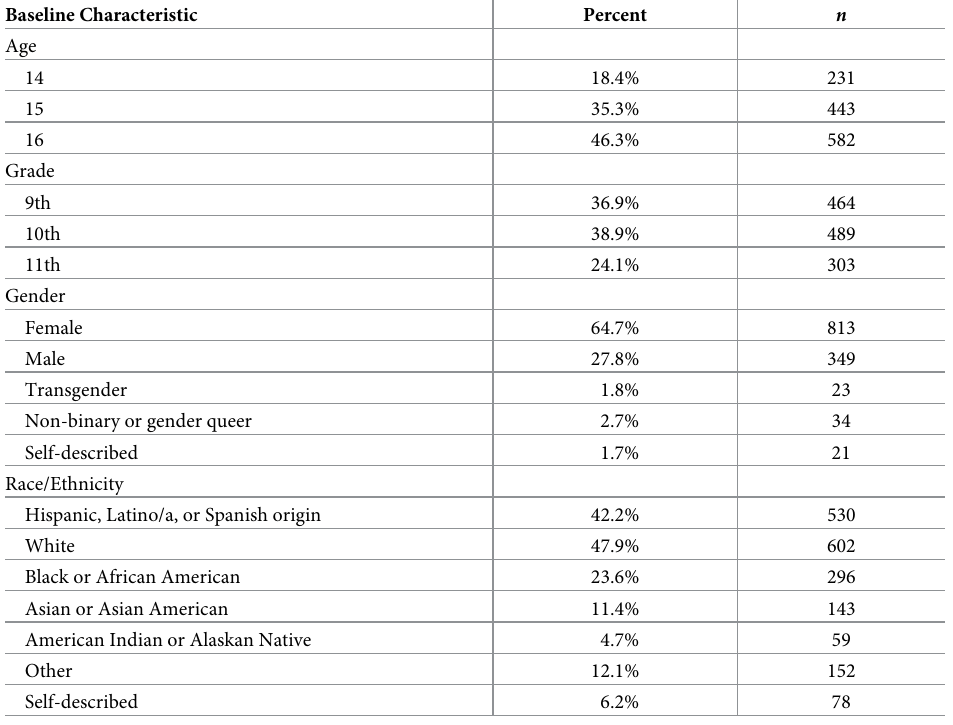
Table 1. Sociodemographic characteristics of